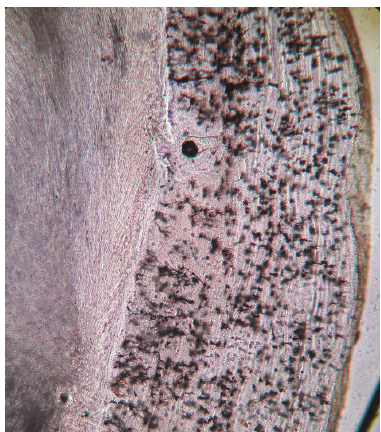
Figure 10: Cemetocytes with canaliculi (photomicrograph, ground section